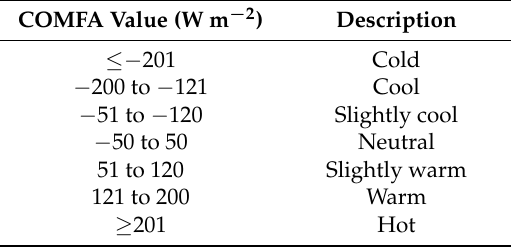
Table 2. Thermal sensations as applied to the COMFA value.